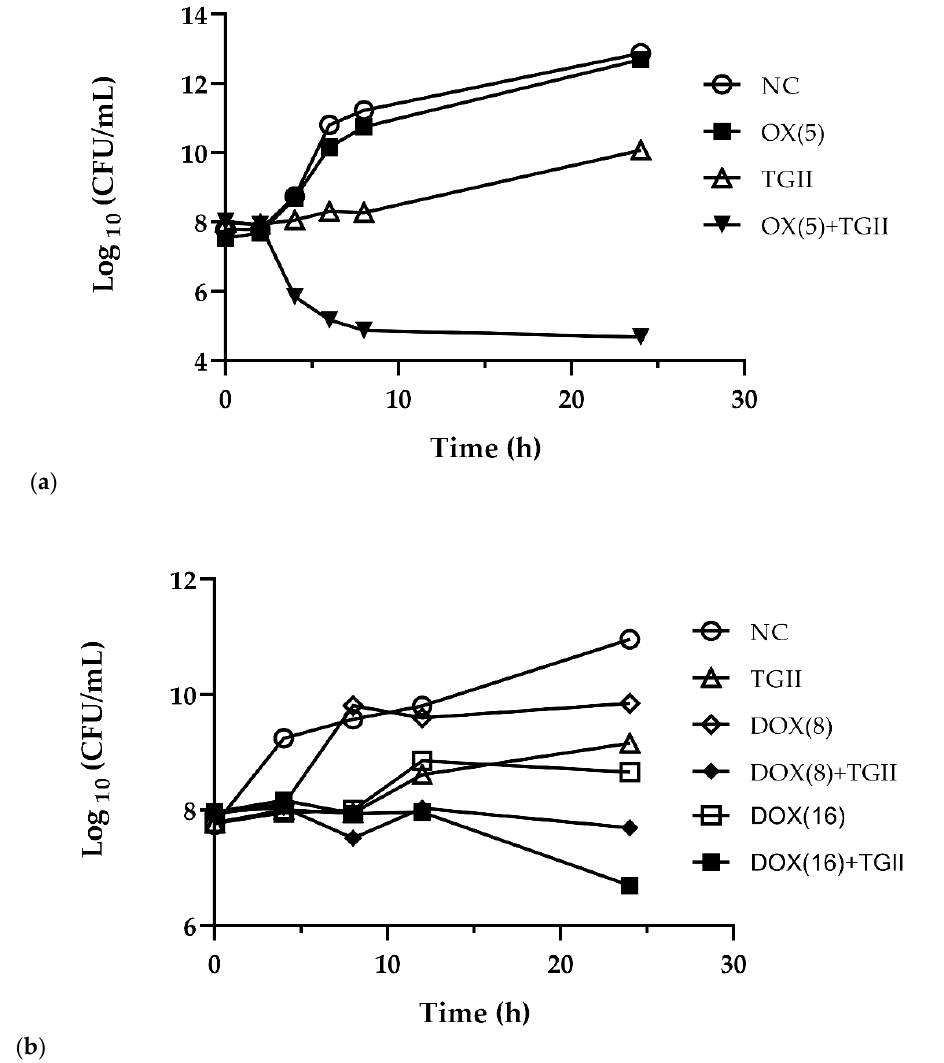
Figure 2. Time-kill kinetics of TGII, ( a ) oxacillin (OX), ( b ) doxycycline (DOX), and TGII combined with OX or DOX against clinically isolated MRSA strain (MRSA 19615). The treatment conditions are represented by the different symbols. NC: negative control; TGII: 40 μg/mL; OX(5): 5 μg/mL; DOX(8): 8 μg/mL; DOX(16): 16 μg/mL. These experiments were repeated at least three times.